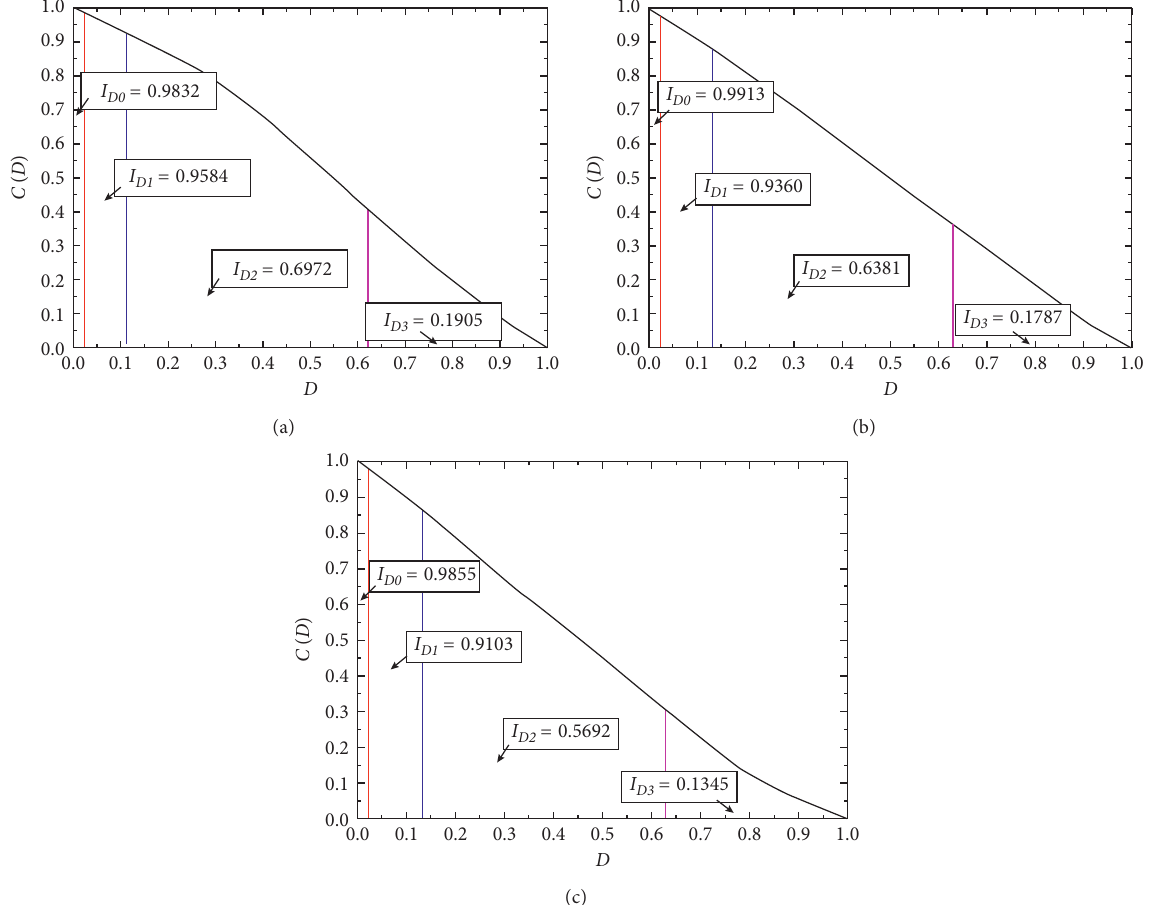
Figure 8: Residual ratio curve of stage seismic capacity. (a) Section R-A. (b) Section R-C. (c) Section